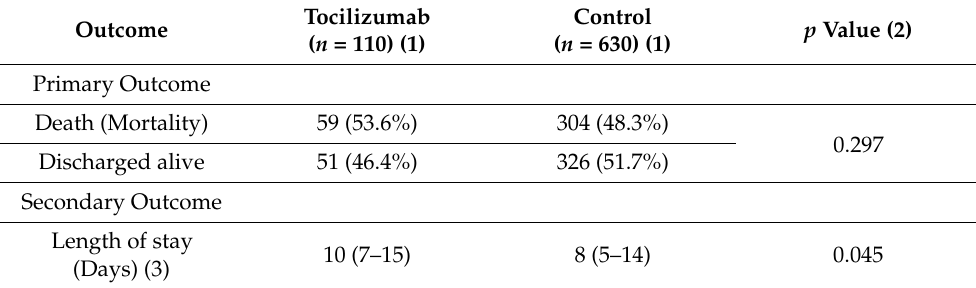
Table 5. Clinical outcomes evaluation between the two groups.